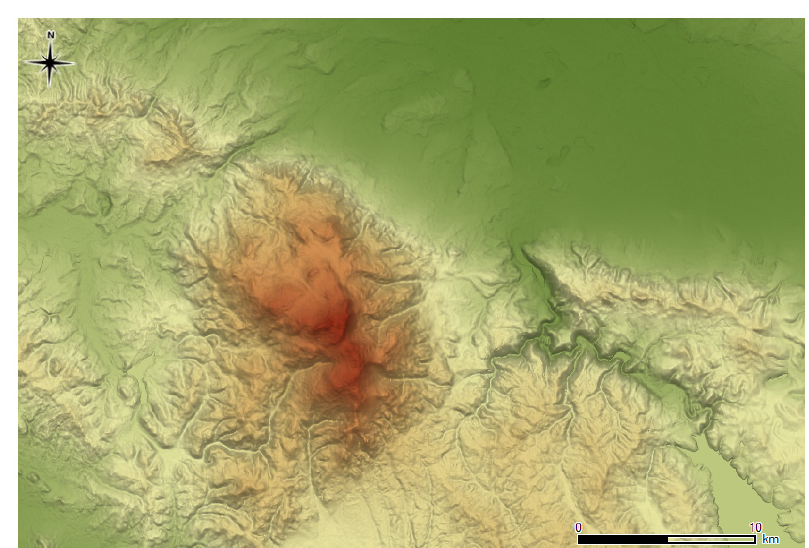
Fig. 8. Colour hypsometric tint with two directional hillshade and slope